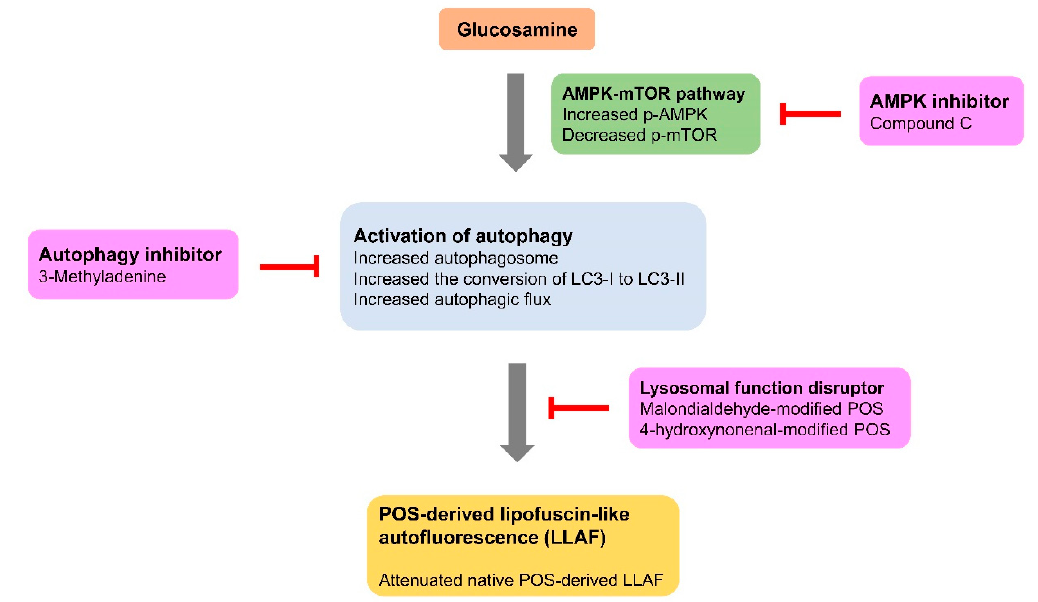
Figure 8. Schematic representation of the Glucosamine (GlcN)-induced autophagy on the native photoreceptor outer segment (POS)-derived lipofuscin-like autofluorescence (LLAF) and the potential pathway associated with GlcN-induced autophagy in ARPE-19 cells.